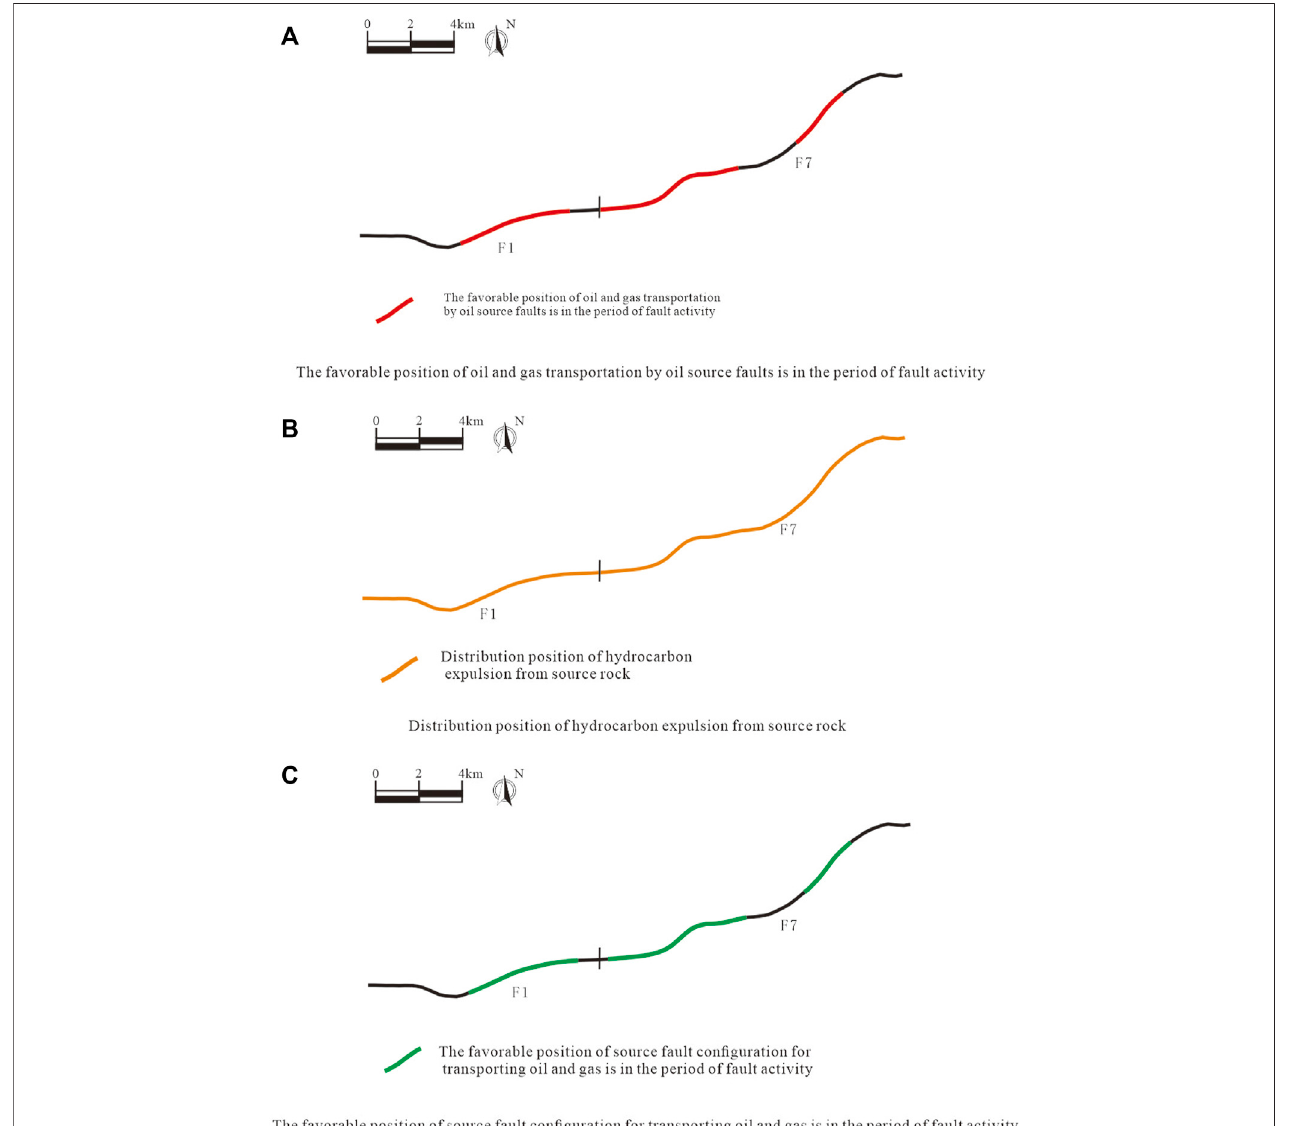
FIGURE9| Themappingofthefavorablepositionofthesourceandfaultcon fi gurationfortransportingoilandgasinthesouthwestoftheJiuzhoufaultinthemiddle and lower sub-member of Es3 during fault activity period.